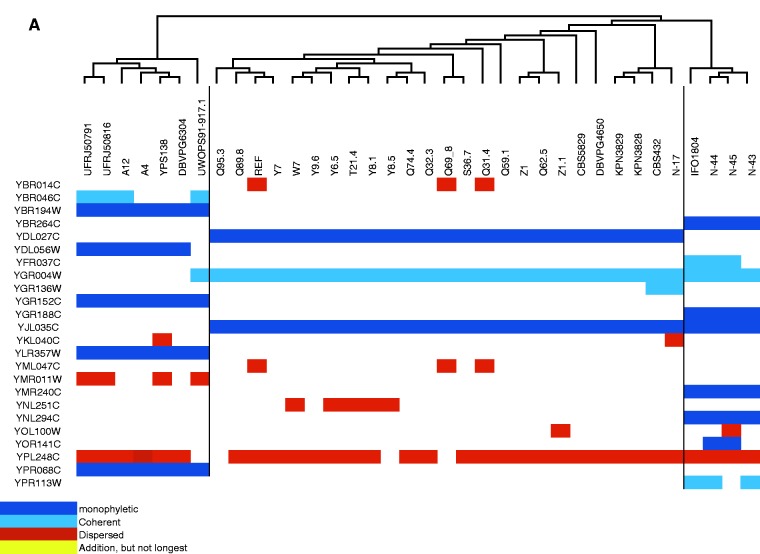
Distribution of addition allele across strains in S. paradoxus (A) and S. cerevisiae (B). Unrooted phylogenetic trees were taken from Liti et al. (2009). As is well-known, S. paradoxus shows more population structure (appearing here as dark blue monophyletic blocks or pale blue “coherent” near-monophyletic blocks) than S. cerevisiae. The strong phylogenetic pattern further demonstrates that these additions are not mere sequencing errors. A number of additions have risen to high frequency.